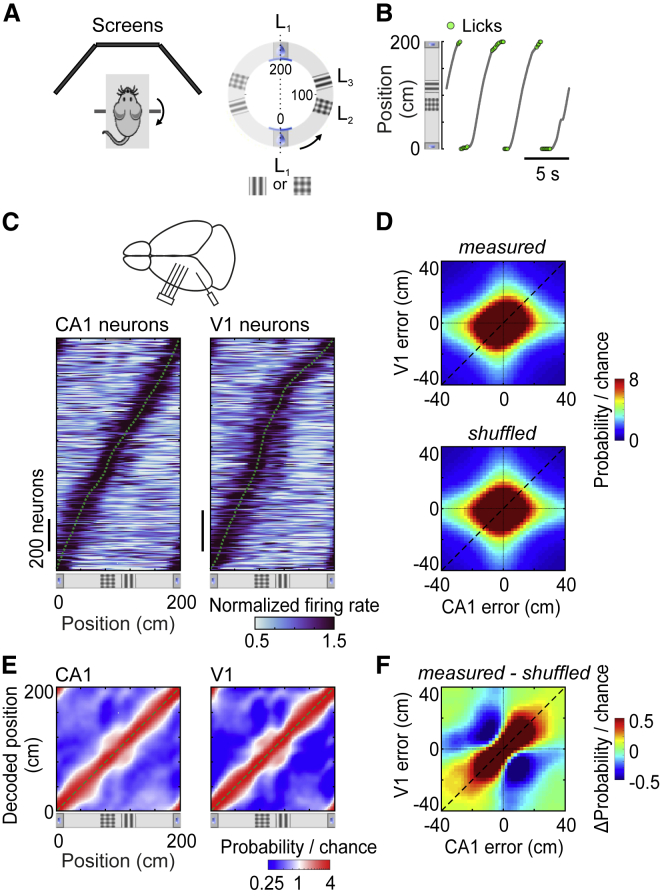
Coherent Spatial Representations in CA1 and V1 in a Visually Unambiguous Environment(A) Schematic of the setup: running wheel surrounded by three screens (left) and virtual corridor with landmarks (L1, L2, and L3, right). See also Figures S1.(B) Example trajectories, showing the locations of licks (green dots).(C) Top: schematic of recordings with silicon probes in hippocampus (CA1) and visual cortex (V1). Shown on the bottom are responses of neurons in CA1 (left, n = 1,431) and V1 (right, n = 1,127) that significantly changed firing rate along the corridor (p < 0.01, permutation test) Neurons are ordered by the position of maximal firing (dotted green curve). Each response was normalized by the mean firing rate across positions.(D) Joint distribution of V1 and CA1 decoding errors, averaged across spatial positions and sessions (n = 27). Shown at the top is the joint distribution obtained from the measured responses. Shown on the bottom is the joint distribution obtained after shuffling time points within position and speed bins.(E) Distribution of positions decoded from CA1 (left) or V1 (right), as a function of the animal’s position, averaged across all trials.(F) Difference between joint distributions of V1 and CA1 errors obtained from measured responses and shuffled control.See also Figure S2.